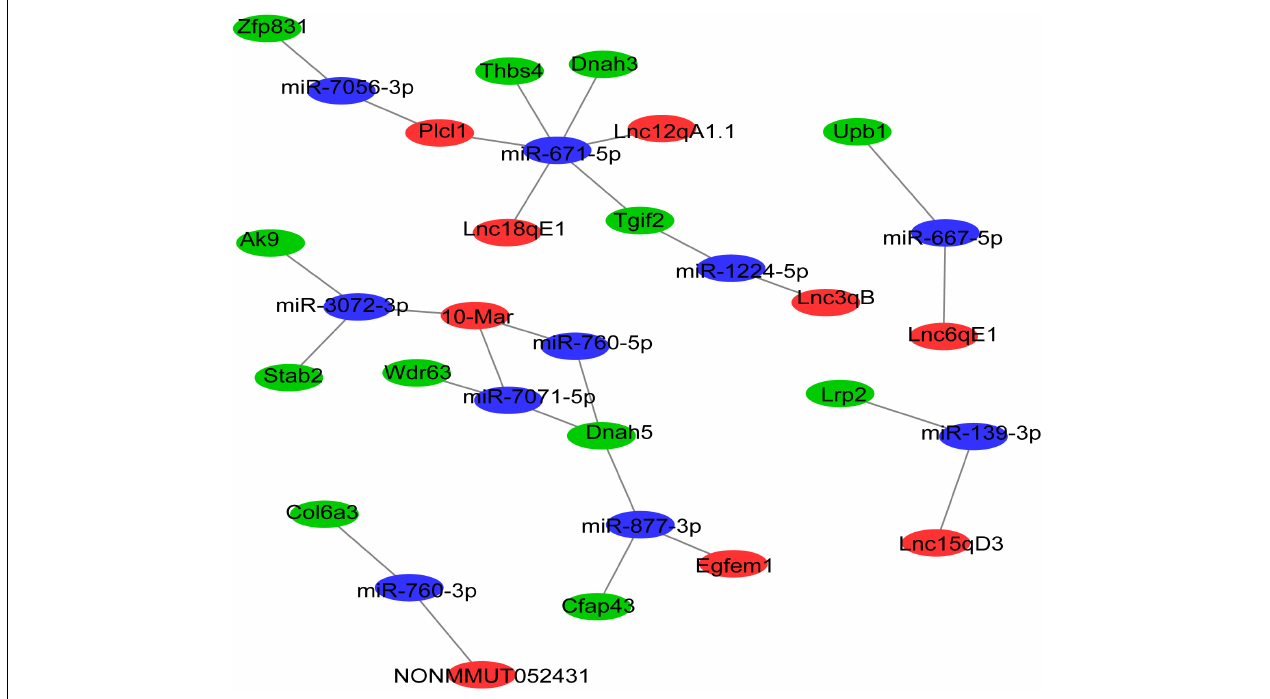
FIGURE 4 | The lncRNA-associated ceRNA networks in morphine/saline treated mice. The ceRNA network was constructed based on identified lncRNA–miRNA and miRNA–mRNA interactions. In the network, red indicates upregulated lncRNAs, blue indicates downregulated miRNAs, and green indicates upregulated